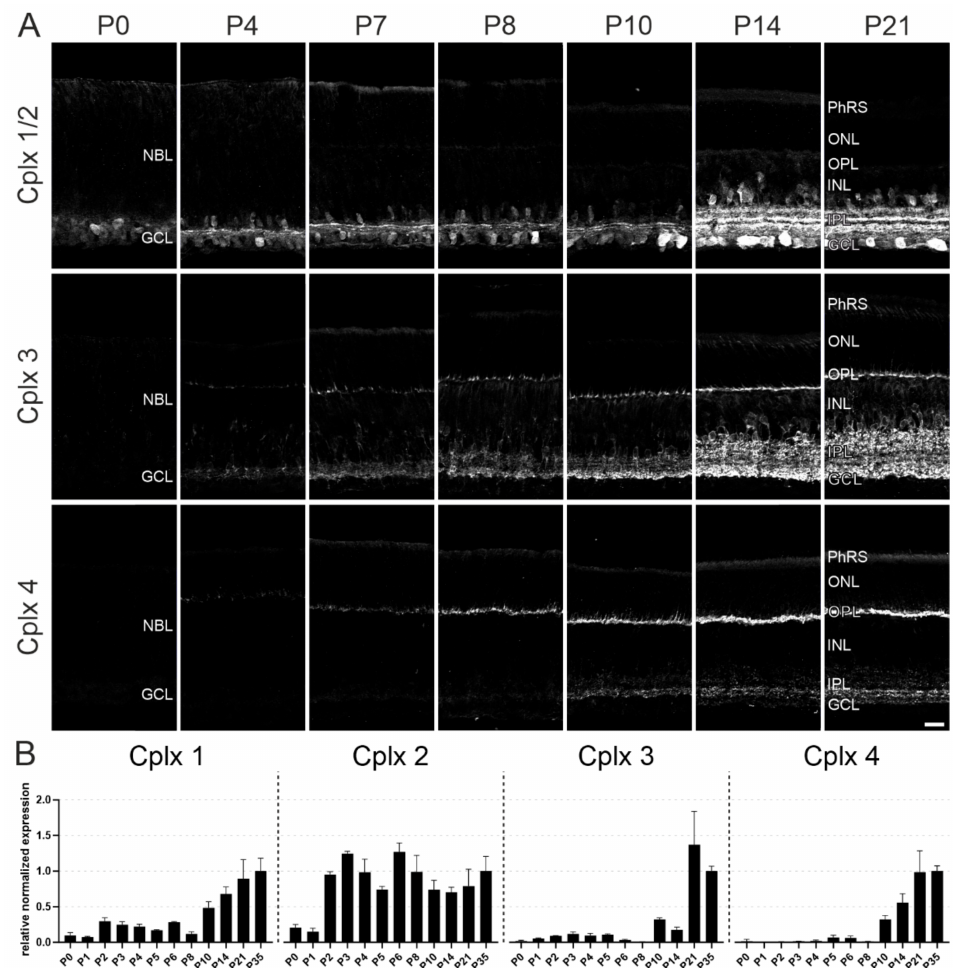
Figure 11. Postnatal developmental expression of Cplxs 1–4 in mouse retinae. ( A ) Fluorescence micrographs of vertical cryostat sections through retinae of wildtype (WT) mice at different postnatal developmental ages stained with antibodies against Cplx 1/2, Cplx 3 and Cplx 4. ( B ) RT-qPCR analysis of Cplxs 1–4 expression in WT retinae at different postnatal developmental ages. Bar graphs display the mean relative normalized expression levels ± SD in three animals per age group. P, postnatal day; NBL, neuroblast layer; PhRS, photoreceptor segments; ONL, outer nuclear layer; OPL, outer plexiform layer; INL, inner nuclear layer; IPL, inner plexiform layer; GCL, ganglion cell layer. Scale bar = 20 µ m in ( A